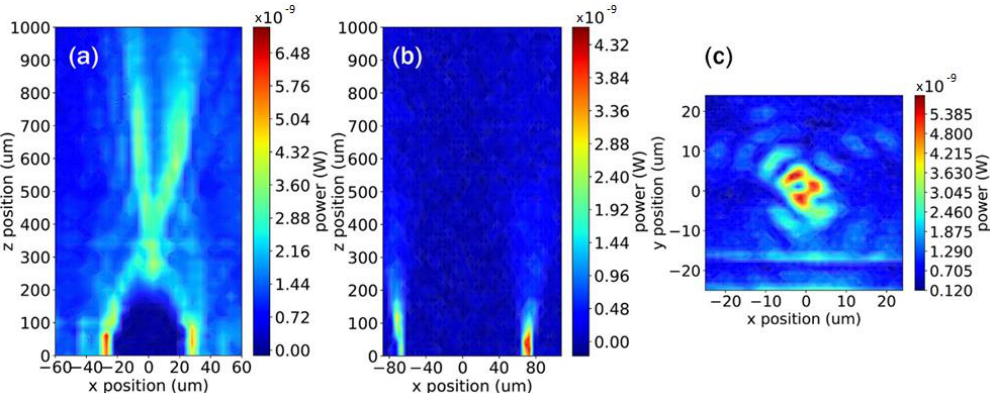
Figure 12. Side views ( a , b ) and top view ( c ) of the 2D emitted power distribution from the grating 310 µm above the chip, showing a focus point 10 µm in structures. Apodized gratings ( a ) allow for light to travel further into the device than the non- apodized gratings ( b ). Top view is the 2D power distribution in the (x-y) plane taken at a height, z 310 µm above the chip, showing a focus point 10 µm in diameter.